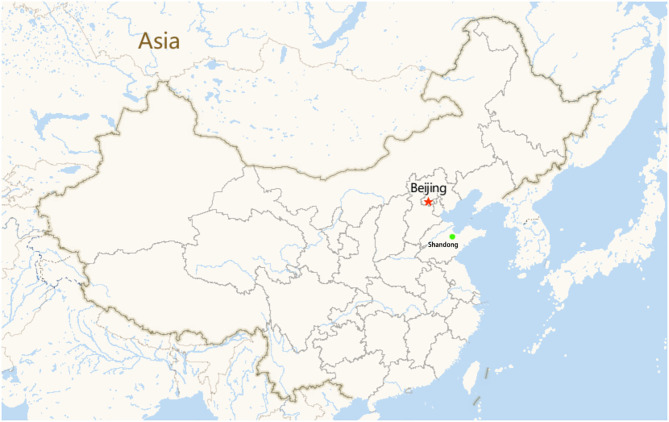
Small geographical map of the farms (the green dots represent the area where the cattle farms are located, the red star represent the capital of China, Beijing).